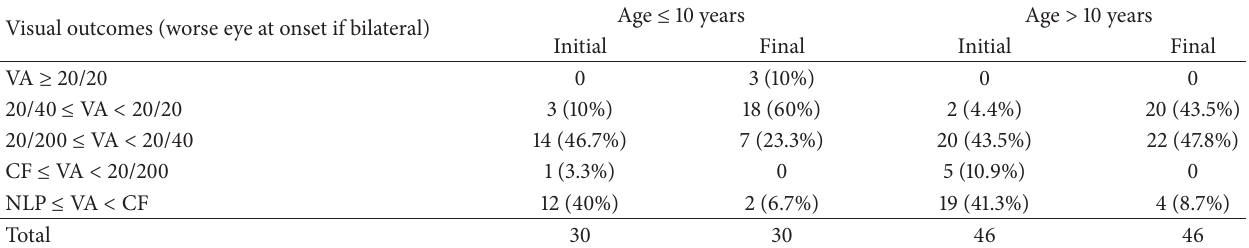
Table 2: Visual outcomes of Chinese children with optic neuritis.